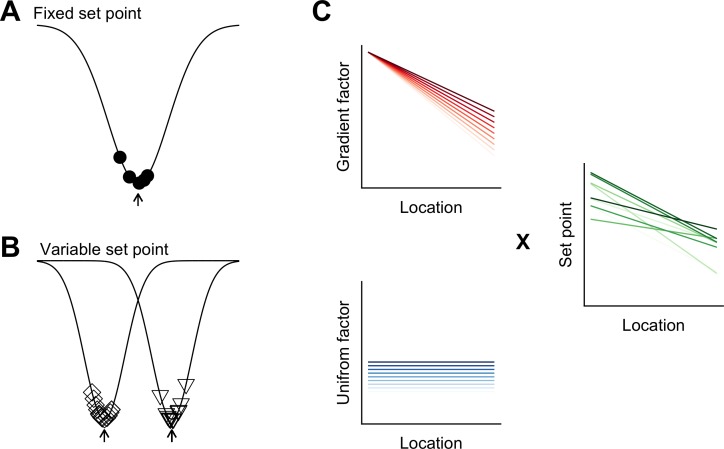
Models for intra- and inter-animal variation.(A) The configuration of a cell type can be conceived of as a trough (arrow head) in a developmental landscape (solid line). In this scheme, the trough can be considered as a set point. Differences between cells (filled circles) reflect variation away from the set point. (B) Neurons from different animals or located at different dorsoventral positions can be conceptualized as arising from different troughs in the developmental landscape. (C) Variation may reflect inter-animal differences in factors that establish gradients (upper left) and in factors that are uniformly distributed (lower left), combining to generate set points that depend on animal identity and location (right). Each line corresponds to schematized properties of a single animal.